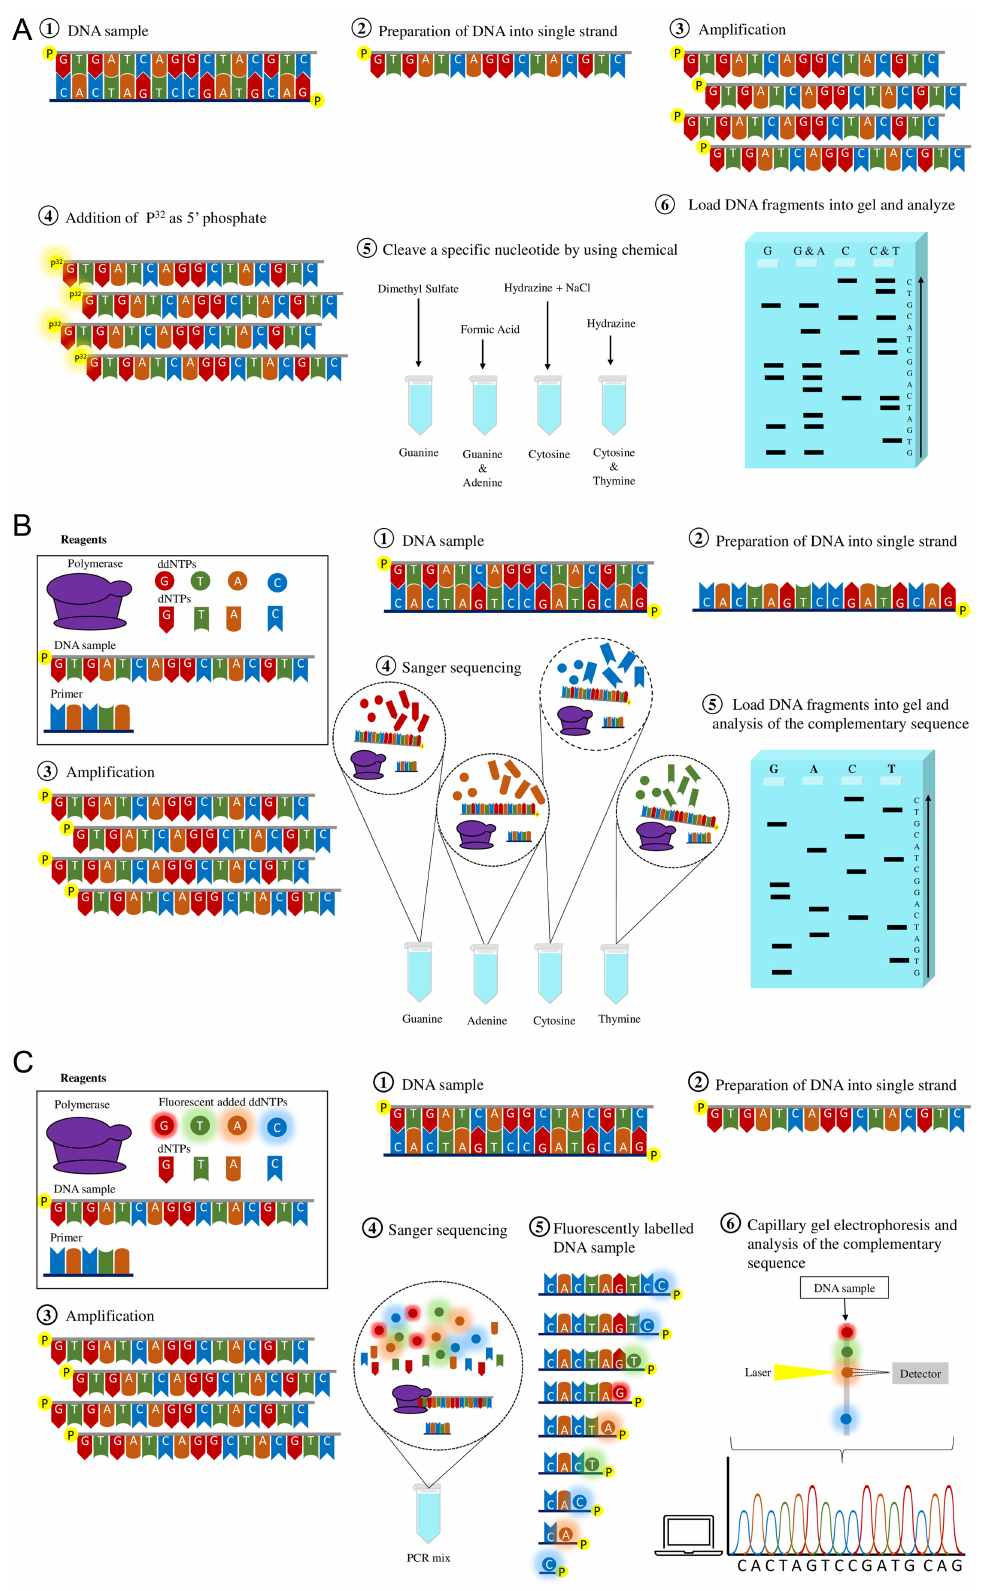
Figure 1. A-C. First-generation sequencing methods; (A) the basic principle of Maxam–Gilbert sequencing method, (B) schematic representation of the old Sanger method, (C) the new Sanger method in its simple form (G: guanine, A: adenine, C: cytosine, T: thymine, P: phosphate, P32: radioactive isotope of phosphorus, ddNTPs: dideoxynucleoside triphosphate, dNTPs: deoxyribonucleotide triphosphate, PCR: polymerase chain